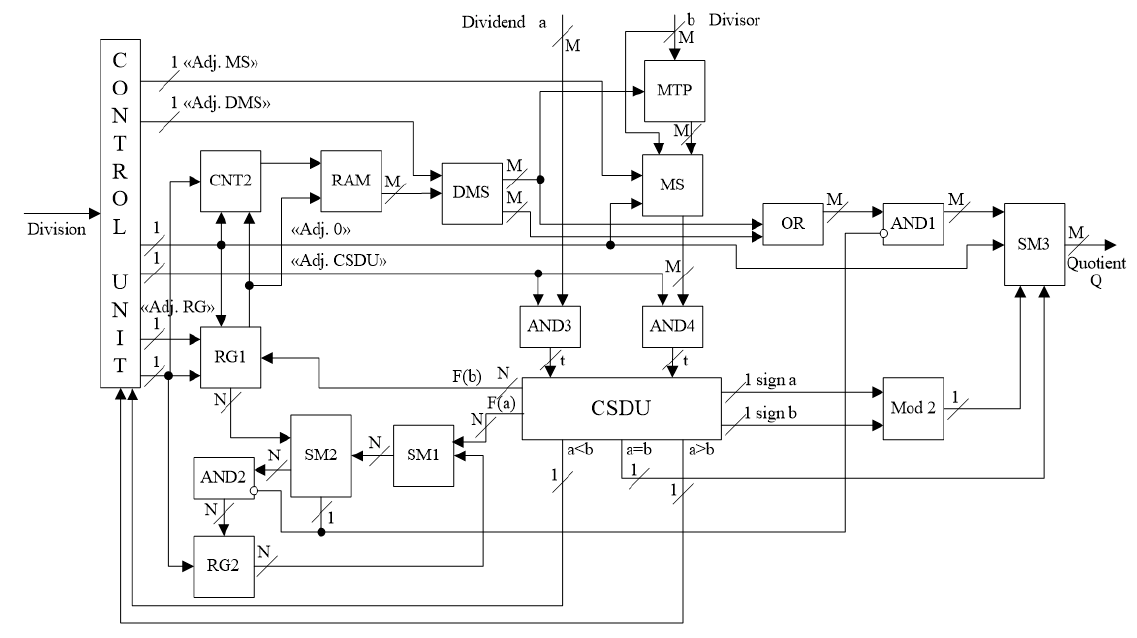
Figure 1. Hardware implementation of new algorithm.